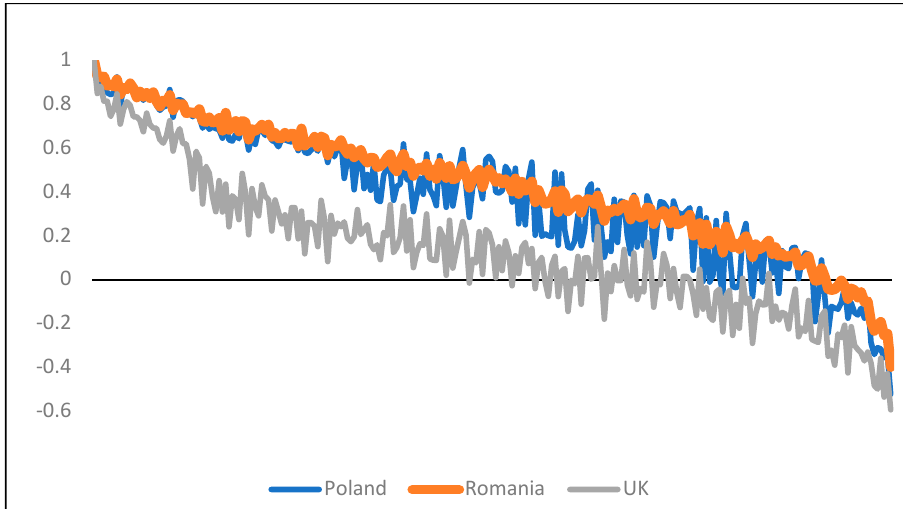
states differed (Figure 3). health